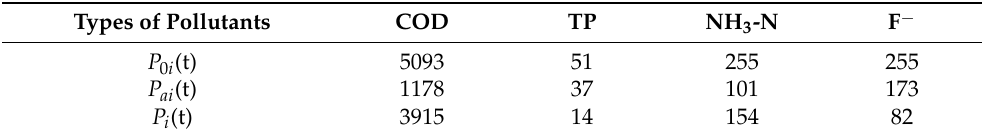
Table 3. Transit volume and reduction of excess pollutants in the Bahao Bridge section under the actual situation in 2018.